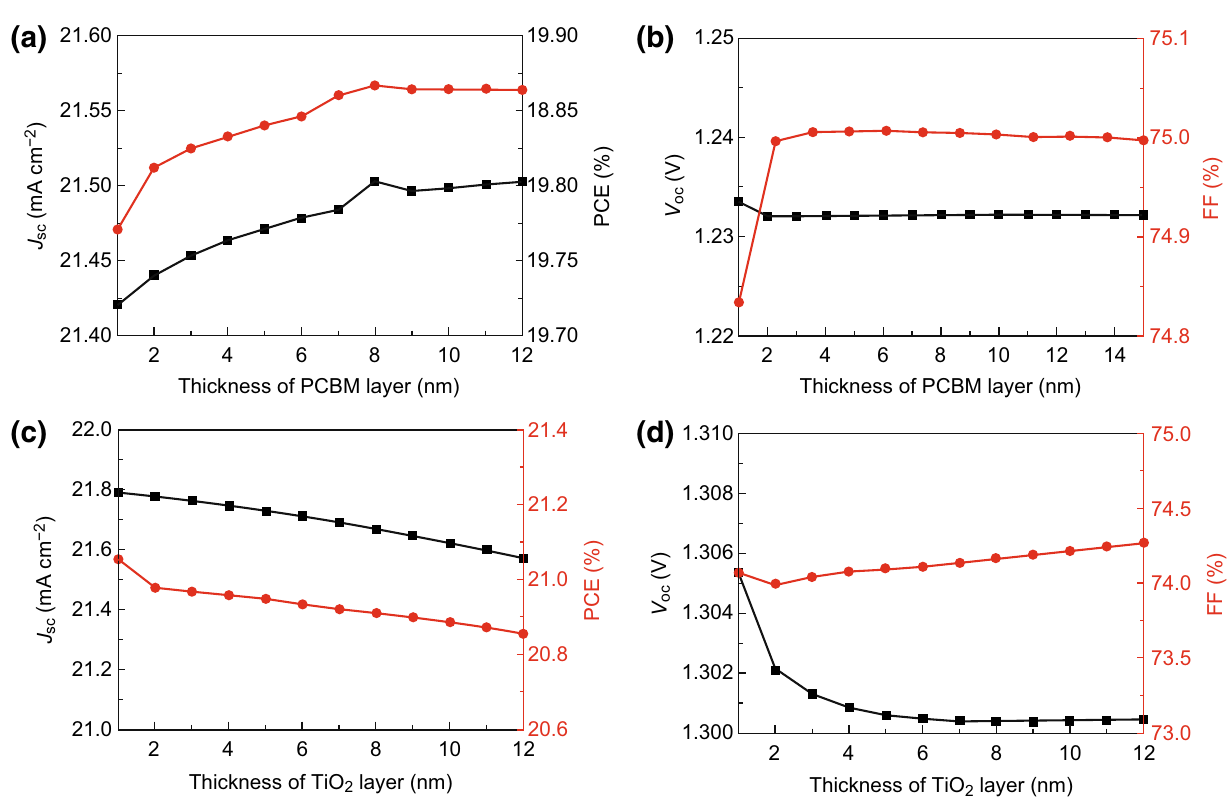
Fig. 6 Device parameters as functions of a , b the thickness of the PCBM layer for a PSC with a PCBM/ZnO bilayer ETL and c , d the thickness of the TiO 2 layer for a PSC with TiO 2 /ZnO bilayer ETL